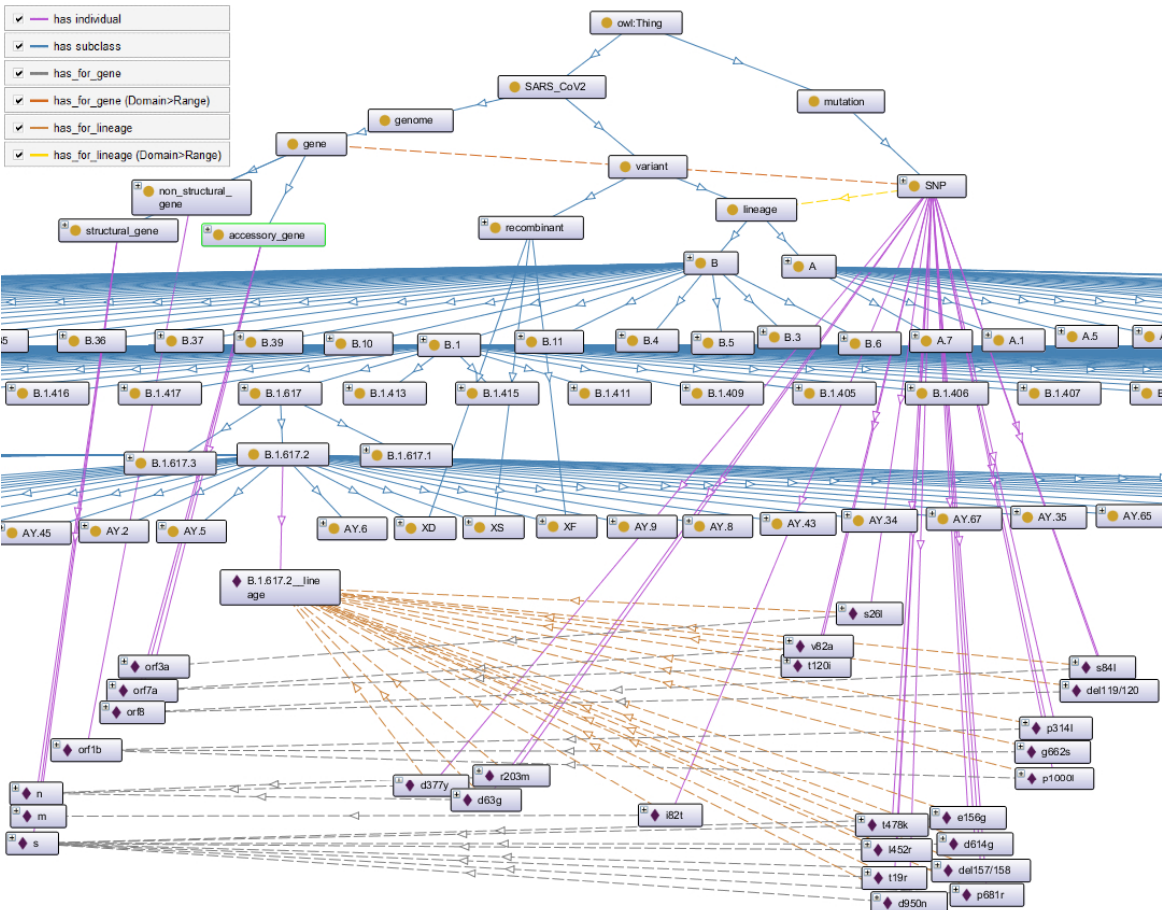
Figure 5. Portion of the ontology that describes the Delta (B.1.617.2)